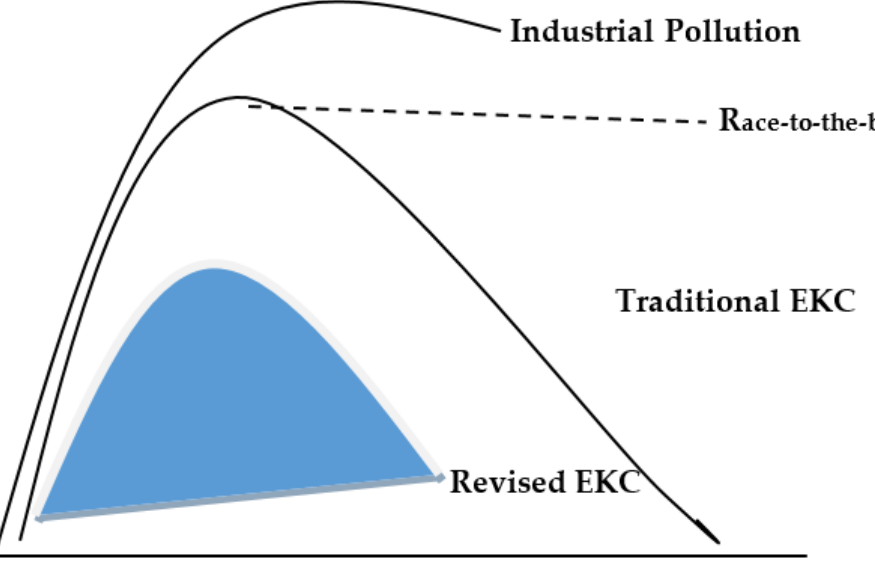
Figure 3. Di ff erent Scenarios of EKC Hypotheses. Source: Adapted from Taguchi Figure 3. Different Scenarios of EKC Hypotheses. Source: Adapted from Taguchi [53].